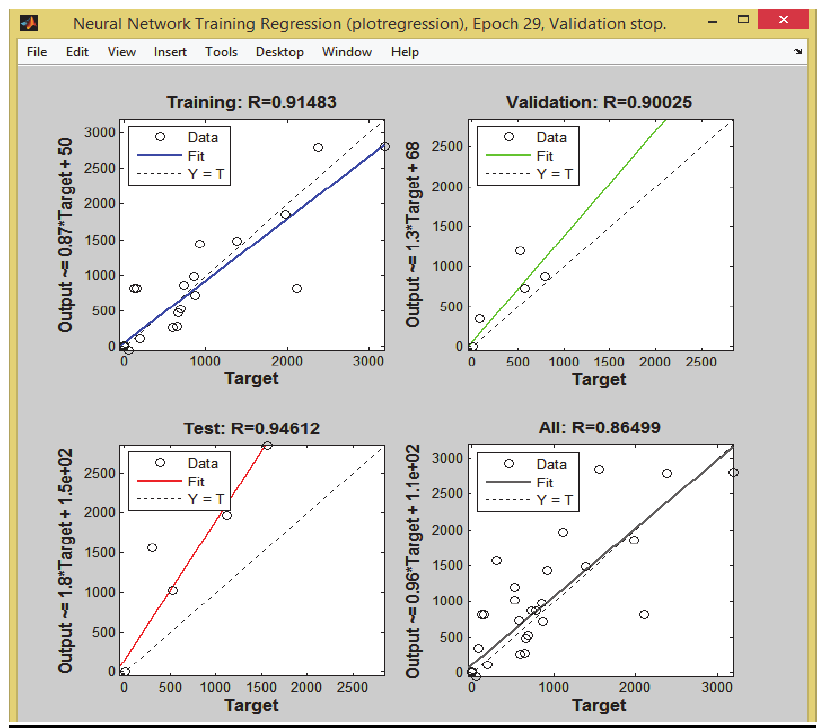
Fig. 13. Compressions between Target and Output of